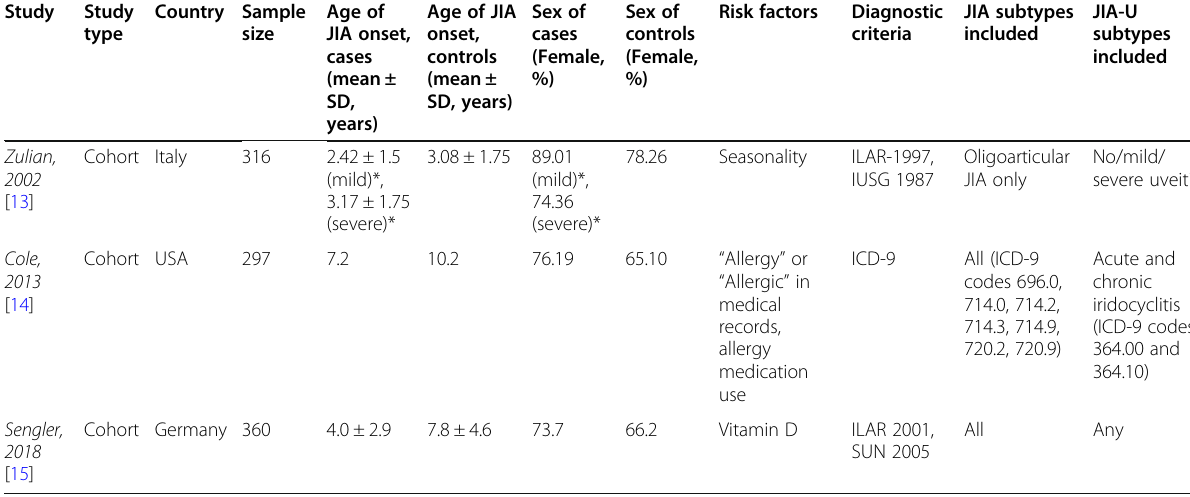
Table 3 Characteristics of included studies. *Demographic data for this study was stratified by uveitis severity. ICD, International Classification of Diseases, ILAR, International League of Associations for Rheumatology; IUSG, International Uveitis Study Group; JIA, juvenile idiopathic arthritis, JIA-U, juvenile idiopathic arthritis associated uveitis; SD, standard deviation; SUN, Standardisation